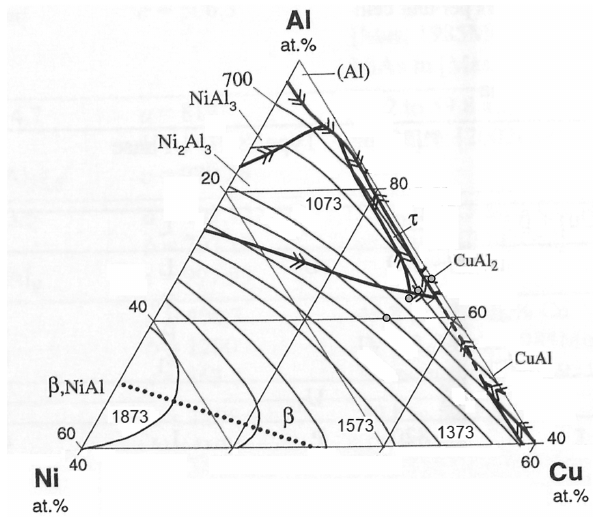
Figure 1: Liquidus projection of Al – Cu – Ni system ( (cid:129) – investigated alloys; τ – ternary Al 31 Cu 16 Ni 4 ).